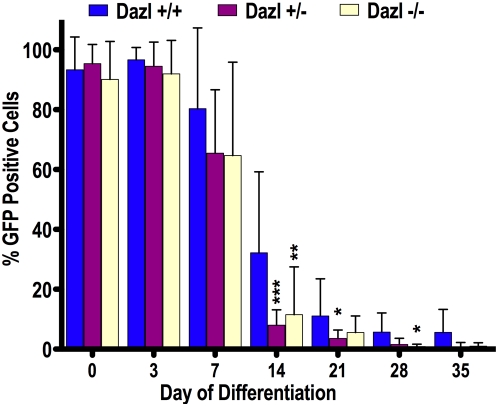

Dazl is required for in vitro Germ Cell Development.Counts of Oct4ΔPE:GFP positive cells in wildtype (+/+), Dazl heterozygotes (+/−), and Dazl-null (−/−) mutant cell lines during a 35-day embryoid body differentiation. Percent GFP positive of all live cells counted is on the y-axis. ‘***’ denotes an extremely significant difference (P<0.001) in percent GFP positive cells relative to wildtype. ‘**’ denotes a very significant difference (P<0.01) in percent GFP positive cells relative to wildtype. ‘*’ denotes a significant difference (P<0.05) in percent GFP positive cells relative to wildtype.